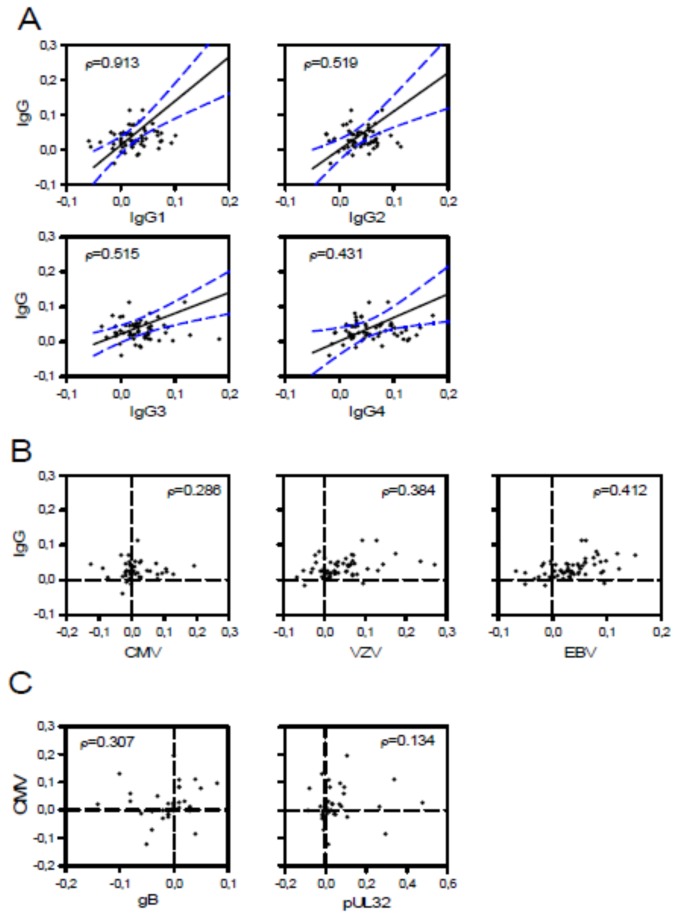
Kinetics of antibody levels in paired samples from CLL patients (n=64).The decay constant λ was calculated as mean change in log10 titer per year. Positive values of λ indicate decay and negative values an increase in antibody levels over time. Statistical analysis was done using Spearman´s rho correlation coefficient which is shown for each comparison. (A) Decay per year of IgG subgroups plotted against total IgG decay. Lines indicate linear correlation and 95% confidence intervals, respectively. Decay of total IgG strongly correlated with that of IgG subgroups, p-values being <0.001 for all comparisons tested (not shown). (B) Decay constants of total IgG plotted against CMV-specific, VZV-specific, and EBV-specific IgG. Correlation between decay constants were statistically significant for total IgG and VZV- and EBV-specific IgG (p-values 0.003 and 0.001, respectively), while correlation between total IgG and CMV- specific IgG was not significant (p=0.087). (C) Decay constants of CMV-specific IgG plotted against CMV-subclass gB-specific and CMV-subclass pUL32-specific IgG. Correlations of decay constants were unspecific for both comparisons (p-values 0.068 and 0.405, respectively).